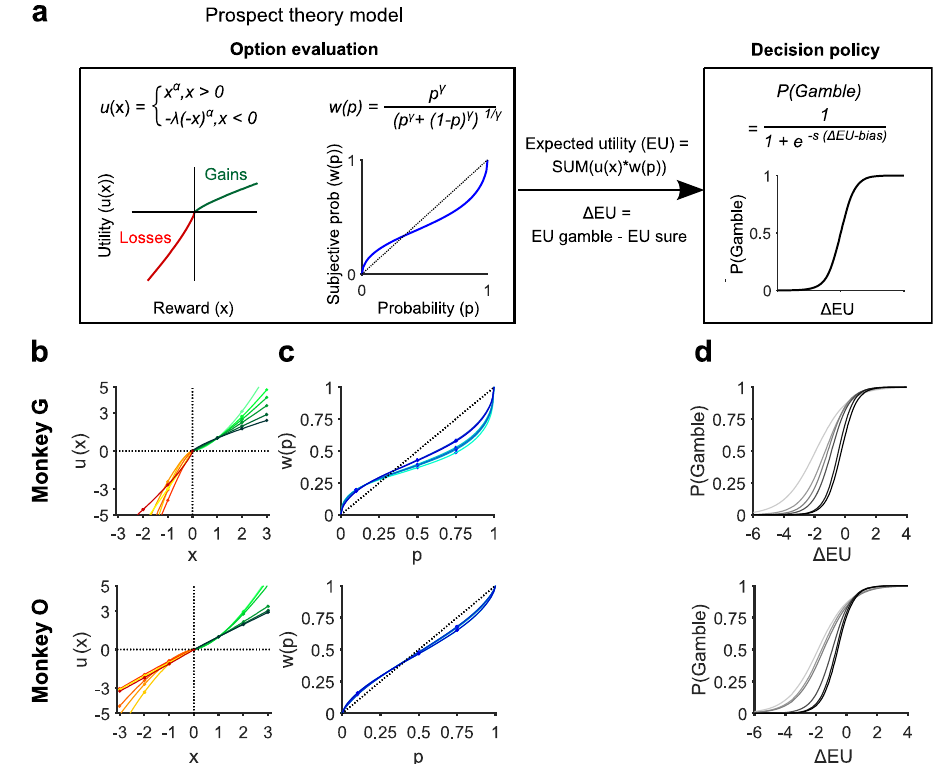
Fig. 2 Behavioral modeling of the prospect theory model. a Behavior modeling. The model consists of two parts: fi rst in the process of option evaluation, the expected utility (EU) of each option was calculated as the product of a utility function and a probability weighting function. Both functions are nonlinear as per the Prospect theory (PT) hypothesized. The expected utility difference between the two options ( Δ EU) was then used to determine the probability of choosing the gamble option via a logistic function -i.e., decision policy. b , c The best fi t utility functions ( b ), probability weighting functions ( c ), and the decision policies ( d ), based on the observed performance. Color gradients represent results from trials with different start token numbers (light to dark: 0 to